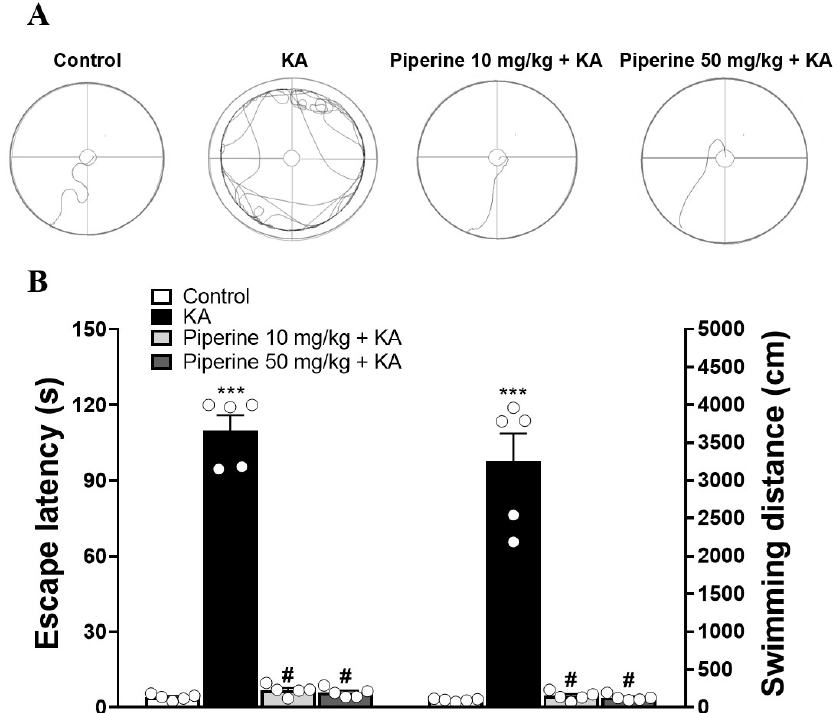
Figure 7. Effect of piperine pretreatment on spatial memory deficits in rats with KA. ( A ) The swimming path of rats in the MWM test. ( B ) Quantitative data of memory deficits are presented in the mean escape latency and mean swimming length. Data are presented as the means ± S.E.M. (n = 5). # p < 0.001 versus the KA group; *** p < 0.001 versus the control group (ANOVA/Scheffé).